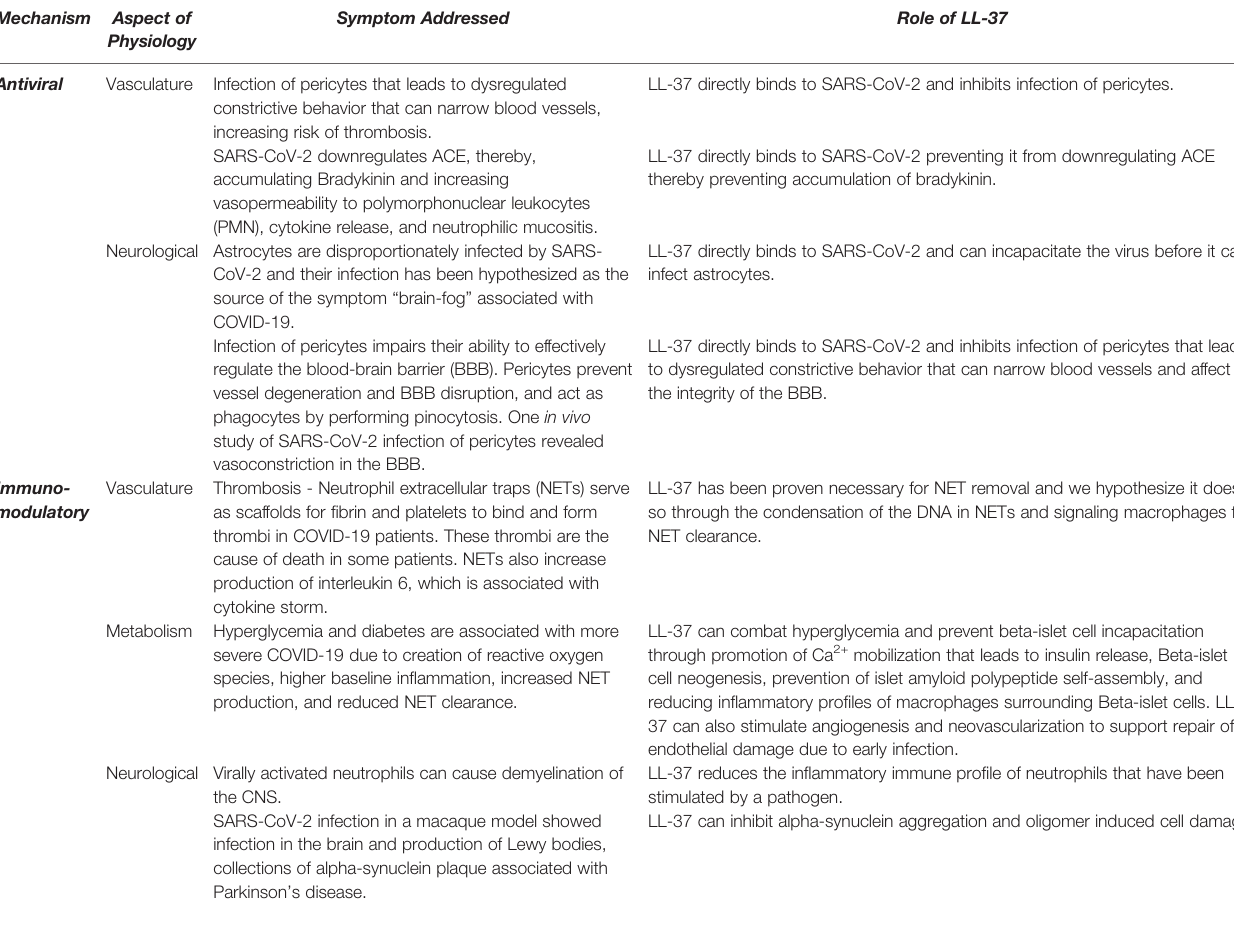
TABLE 1 | List of potential therapeutic effects of LL-37 against COVID-19 separated based on mechanism of action and system targeted. Mechanism Aspect of